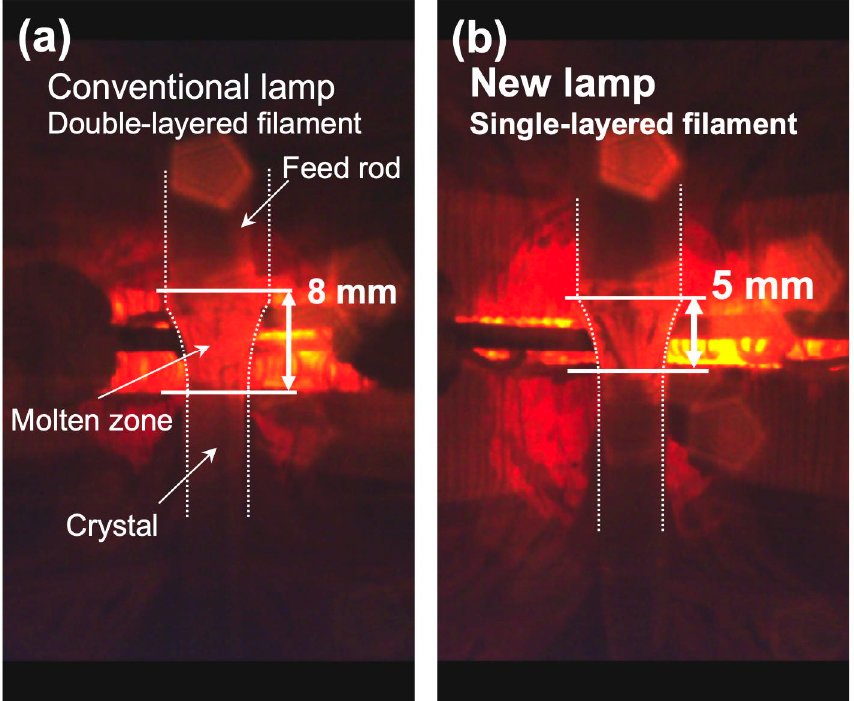
Figure 3. Crystal growth of Sr 2 RuO 4 with ( a ) conventional halogen lamps with double-layered filament and ( b ) new lamps with single-layered filament. A narrower molten zone is obtained by using the new lamp. For clarify, dotted lines and curves are added for guides.